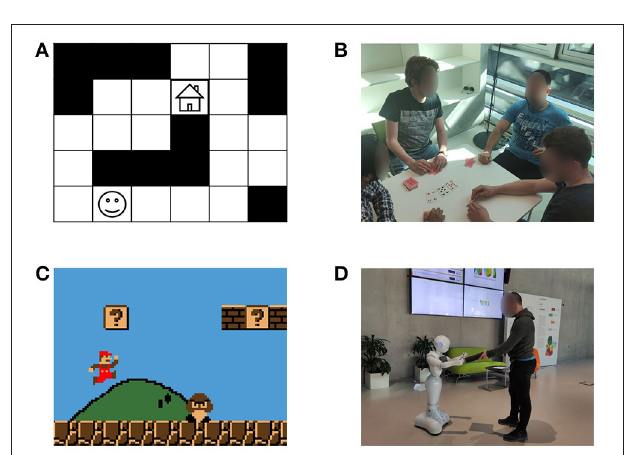
FIGURE 2 | Examples of scenarios of different characteristics, (A) is a grid navigation scenario (agnostic, no intervention, fully observable, deterministic, discrete, single agent), (B) is a poker game (adversarial, direct communication, partially observable, stochastic, discrete, multiagent), (C) is a platform video game (agnostic, no intervention, partially observable, deterministic, continuous, single agent), (D) is a human-robot collaboration scenario (intended, online intervention, partially observable, stochastic, continuous, single